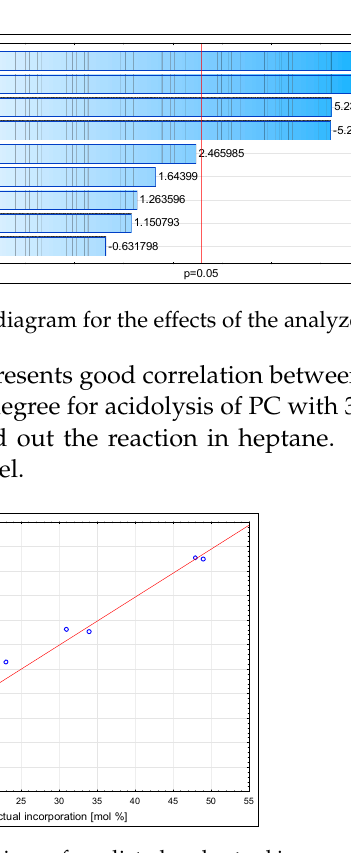
Figure 4. Comparison of predicted and actual incorporation of 3-OMe-CA into phospholipid frac- tion.